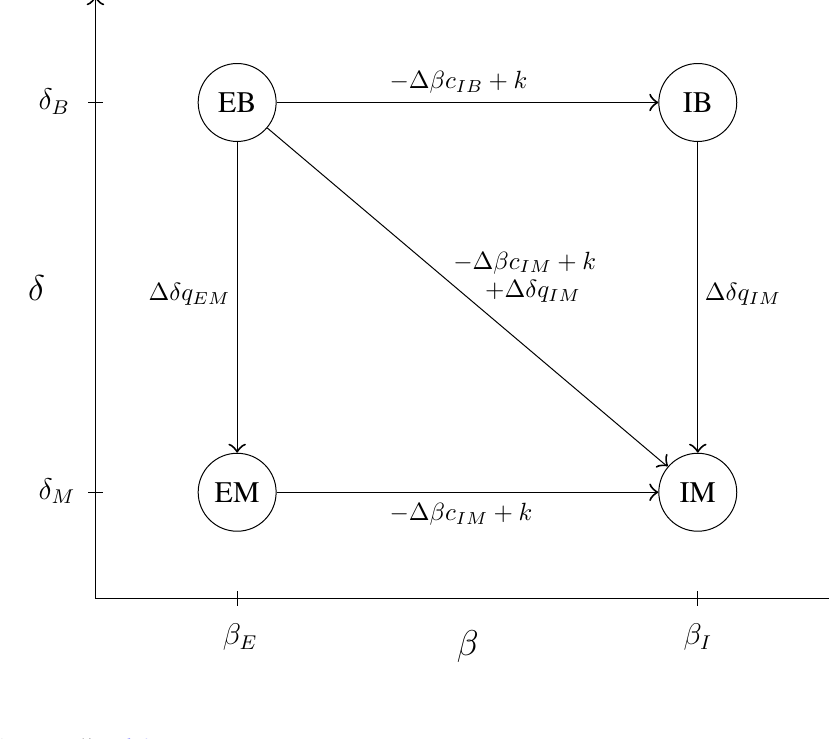
Figure 2. Incentive constraints that are binding in Case